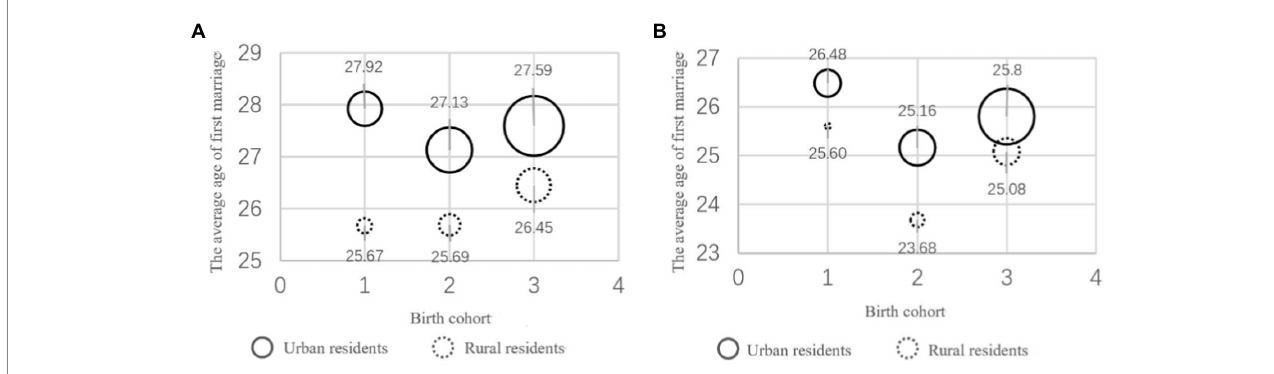
FIGURE 2 Population distribution by generation, urban and rural, and the average age distribution at first marriage. (A) Male residents. (B) Female residents. The numbers 1, 2, and 3 on the horizontal axis represent the first, second, and third generations, respectively. 2. The size of the bubble corresponds to the proportion of the population with higher